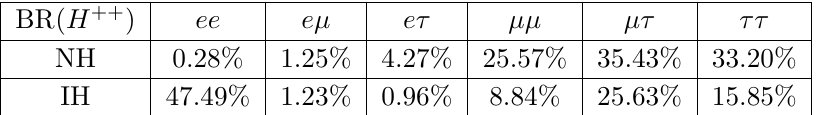
Table 2 . Benchmark decay branching ratios of doubly charged Higgs for NH and IH spectra. They are obtained by fixing the neutrino mass and mixing parameters at their best-fit values, and the lightest neutrino mass is assumed to be m = 10 − 4 eV for NH (IH). We assume vanishing 1(3) Majorana phases.